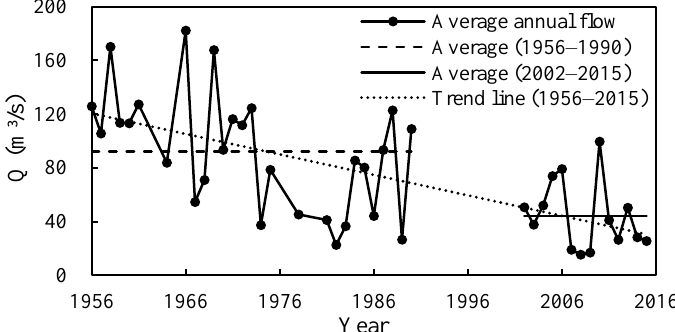
Figure 4. Change in average annual flow at the Burqin hydrological station.